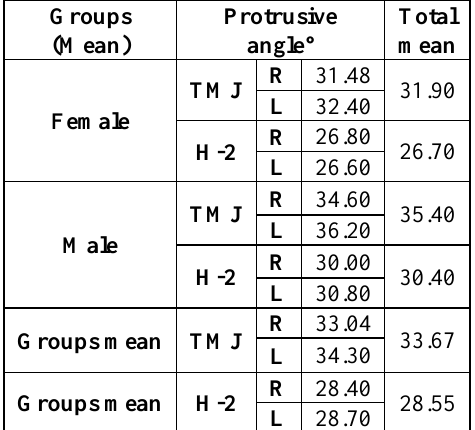
Table 7: Descriptive Statistics of the Detailed Group Mean Values of the Female and Male Patients Concerning the Right and Left Joints' Protrusive Angles.